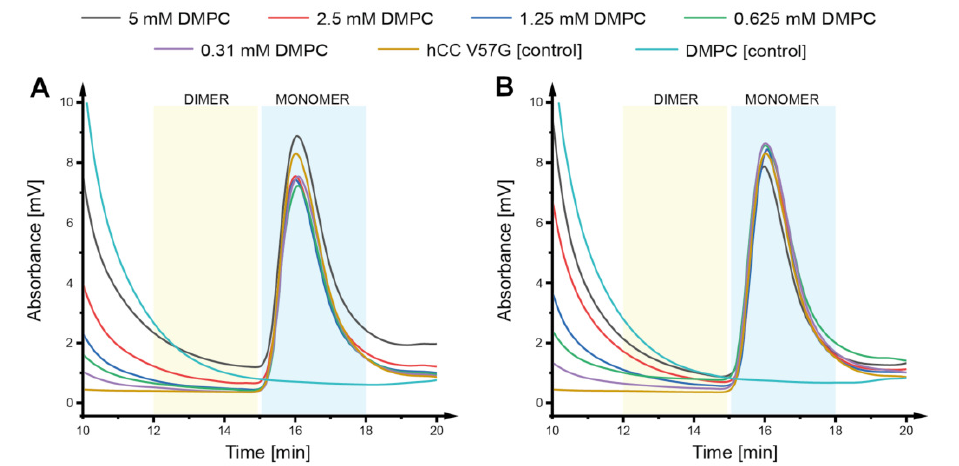
Figure 2. Chromatograms visualizing separation of h CC V57G monomer on the SEC column after incubation at ( A ) 22 ◦ C and ( B ) 37 ◦ C for 24 h in the DMPC solution; monomer retention time—16 min. The h CC:liposome ratio calculated for C DMPC = 5 mM, equaled 48 hCC molecules per